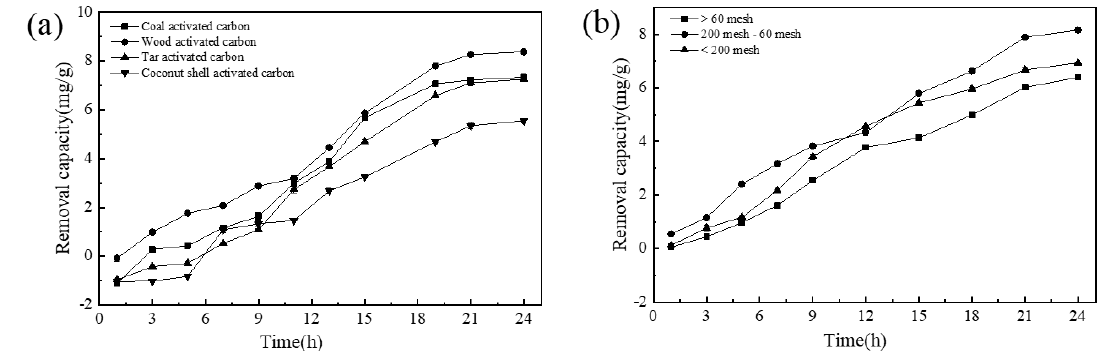
Figure 3. ( a ) Effect of activated carbon type on NICLS removal capacity; ( b ) effect of activated carbon particle size on NICLS removal capacity (activated carbon is wood activated carbon).